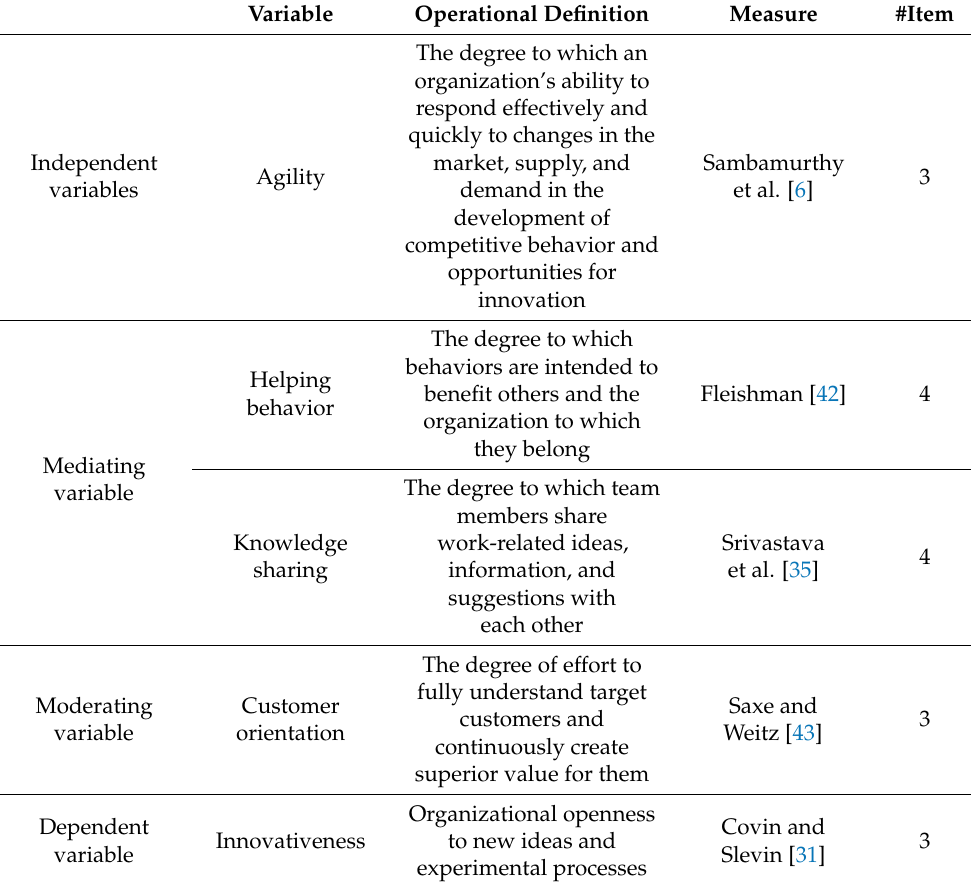
Table 3. Definition and measurement of